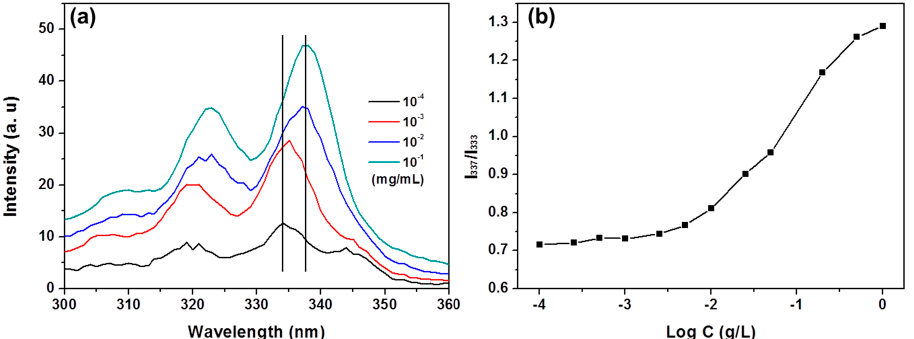
Figure 2. ( a ) Fluorescence excitation spectra of pyrene in aqueous poly(ethylene glycol)-cholesteryl conjugate (Chol-ss-PEG-ss-Chol); and ( b ) intensity ratios ( I 337 / I 333 ) of Chol-ss-PEG-ss-Chol as a function of log concentration.